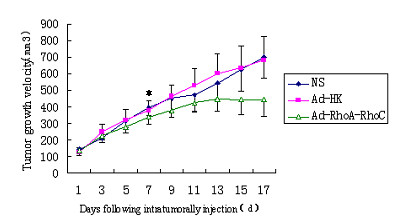
Growth curve of subcutaneous implanted tumors in nude mice treated with NS, Ad-HK, or Ad-RhoA-RhoC. Tumor volume is plotted against time elapsed. A significant delay in tumor growth is seen in the group treated with Ad-RhoA-RhoC. Data are presented as means±SD (n = 7). * P < .05, from this point onwards.